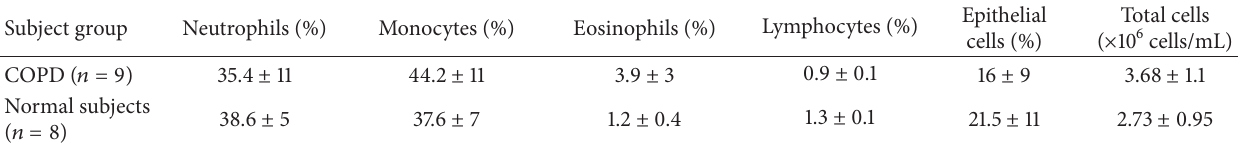
Table 2: Differential counts of SP samples from COPD patients and normal